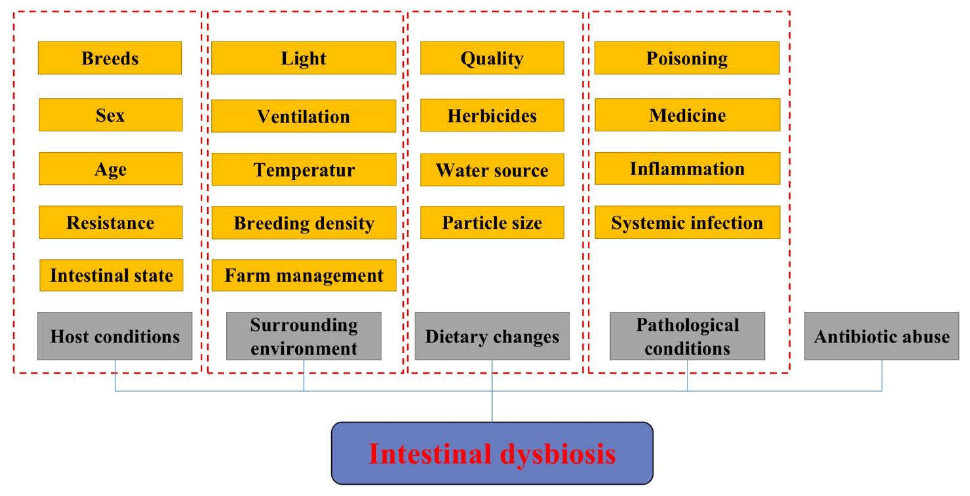
Figure 1. Main factors affecting the composition of animal gut microbiota.